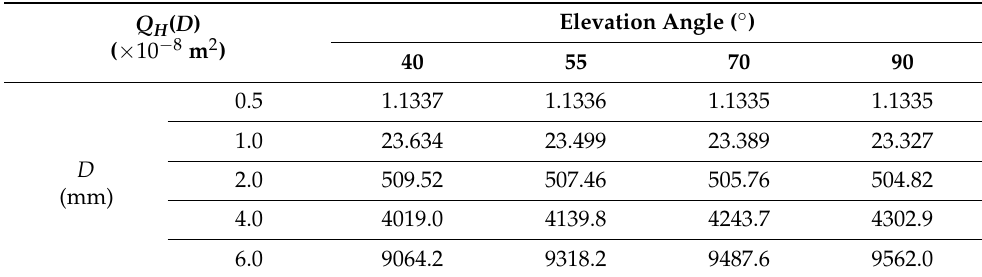
Table 1. The extinction cross section for horizontal polarization calculated by the T-Matrix method for various raindrop sizes and elevation angles.